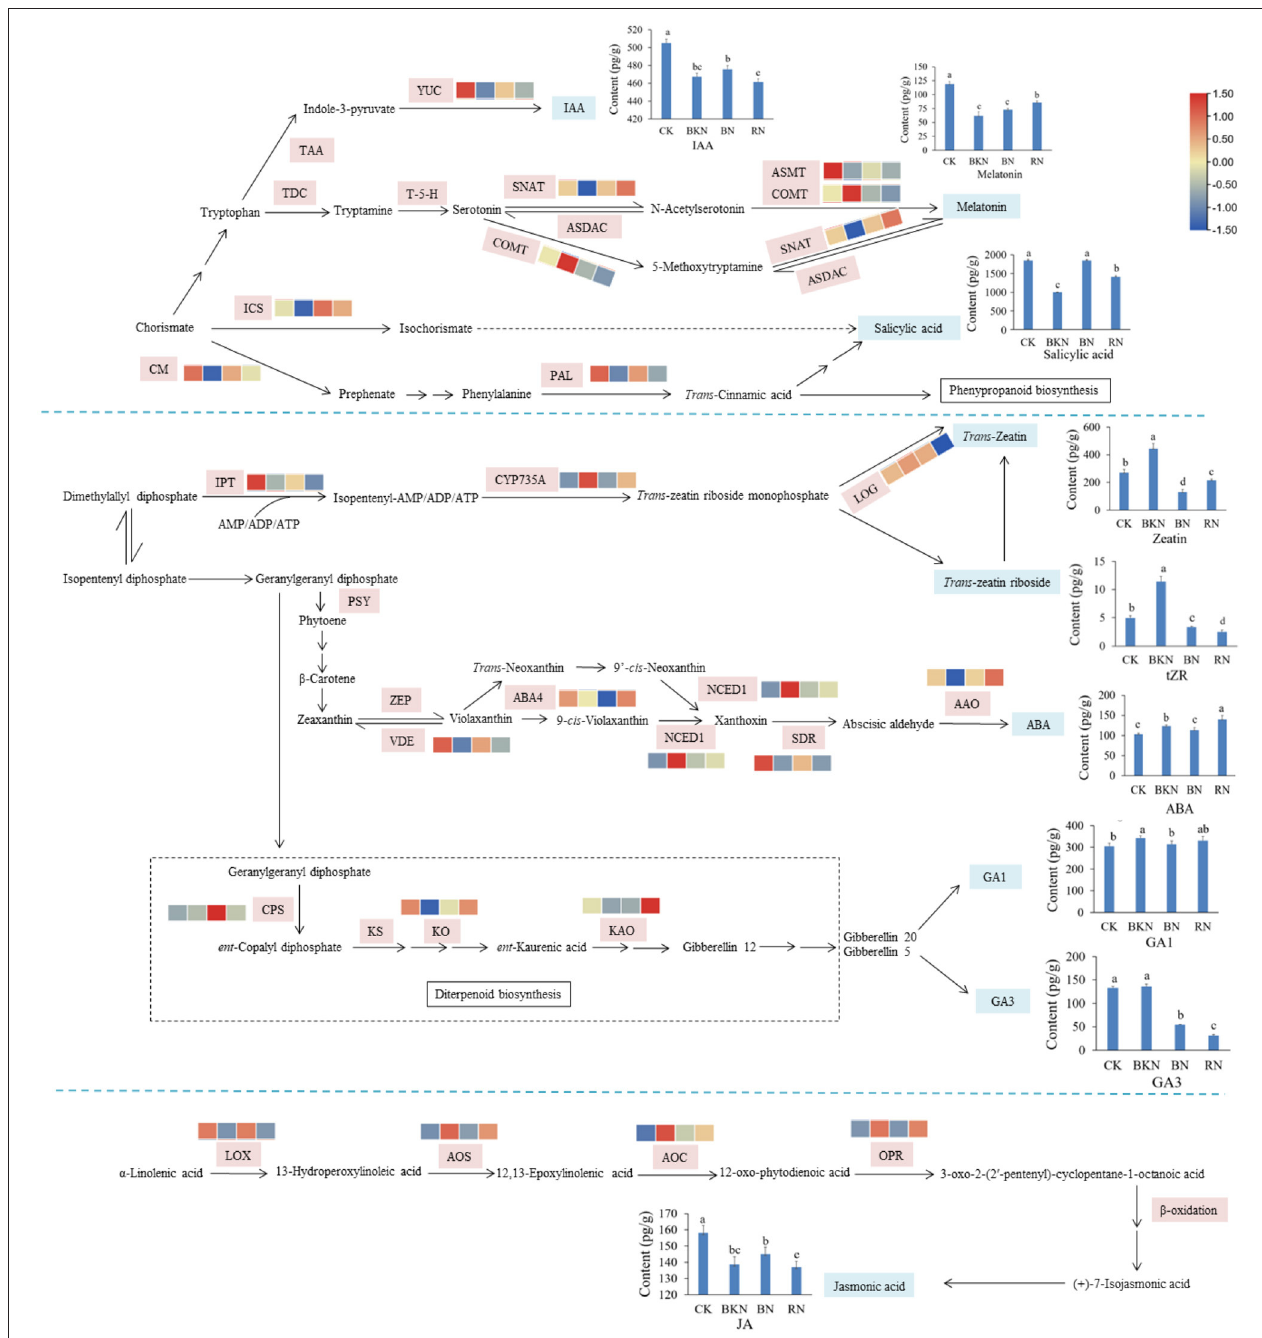
FIGURE 3 | Visualization of the expression levels of the structural genes in the biosynthetic pathway of phytohormones in tea leaves. The contents of 8 detected phytohormones annotated with their structures are shown by line charts. CK, tea sample without shade; BKN, black net shade-treated sample; BN, blue net shade-treated sample; RN, red net shade-treated sample. PAL, phenylalanine ammonia-lyase; CM, chorismate mutase; ICS, isochorismate synthase;YUC:indole-3-pyruvate monooxygenase; IPT, adenylate isopentenyltransferase; CYP735A, cytokinin hydroxylase; CYP714B2, cytochrome P450 714B2; LOG, cytokinin riboside 5 ′ -monophosphate phosphoribohydrolase; AMP, adenosine 5 ′ -monophosphate; NCED, 9- cis -epoxycarotenoid dioxygenase; SDR, short chain dehydrogenase/reductase; MoCo, molybdenum cofactor; CYP707A, abscisic acid 8 ′ -hydroxylase CYP707A; SNAT, serotonin-N-acetyltransferase; ASMT, N-acetylserotonin methyltransferase; COMT, caffeic acid- O -methyltransferase; CPS, ent -copalyl diphosphate synthase; KO, ent -kaurene oxidase; KAO, ent -kaurenoic acid oxidase; 20ox, Gibberellin 20; LOX, lipoxygenase; AOS, allene oxide synthase; AOC, allene oxide cyclase; OPR, 12-oxophytodienoate reductase; JAR, jasmonoyl-L-amino acid synthetase; JMT, jasmonate O -methyltransferase.